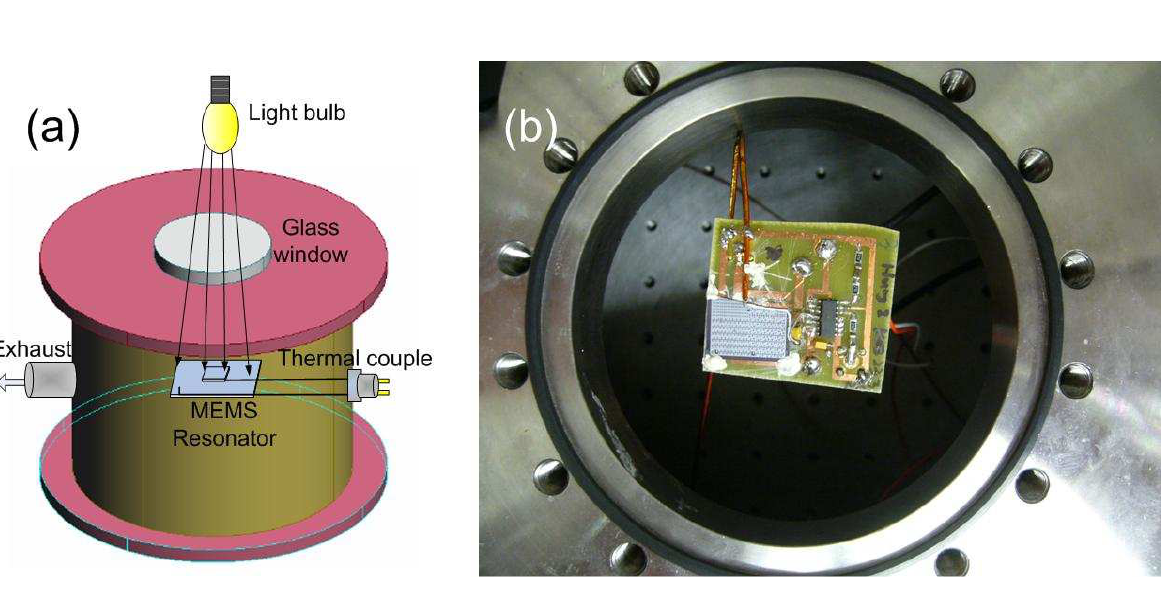
Figure 5. The temperature testing setup: (a) Schematic of the heating source and (b) optical photograph showing the position of the PCB that contains the test chip and associated electronics with respect to the chamber window.